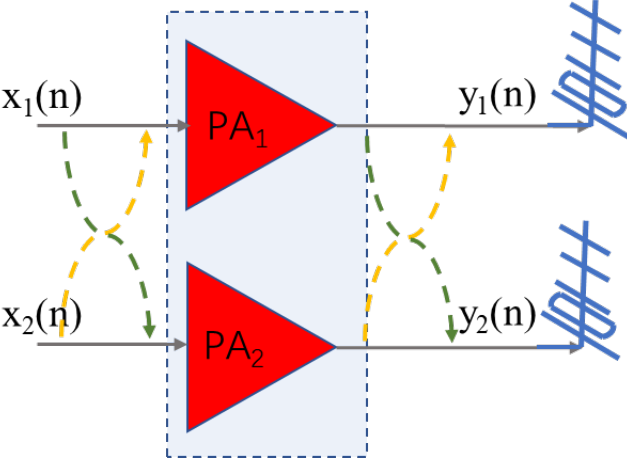
Figure 1. Simplified representation of a 2 × 2 MIMO transmitter.